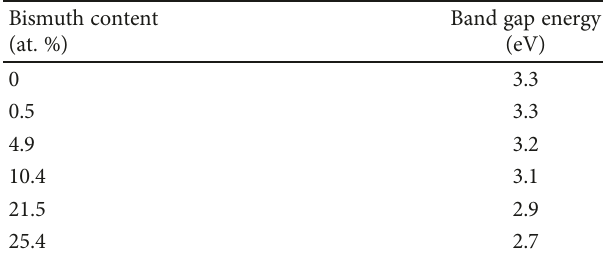
Figure 7: Gaussian deconvolution of the XPS spectra, Bi 4f7/2 region (a) 0.5, (b) 21.5, and (c) 25.4 at. % of bismuth. Table 2: E ff ect of bismuth content on the band gap